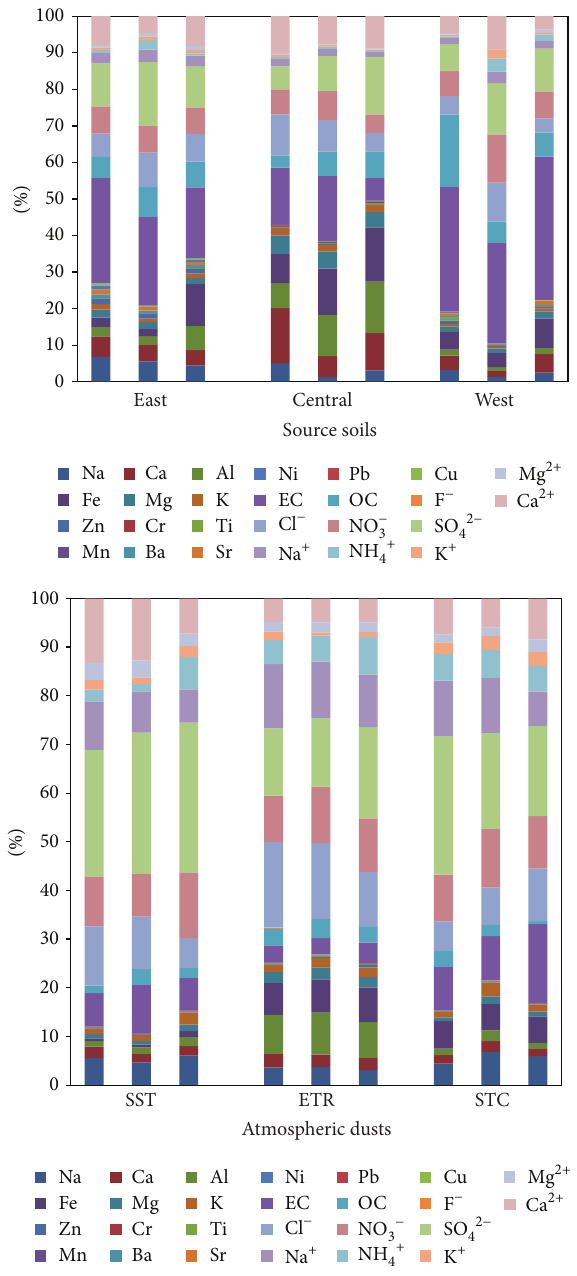
Figure 4: Chemical fingerprints of resuspended source soils and atmospheric dusts during the ADS events.